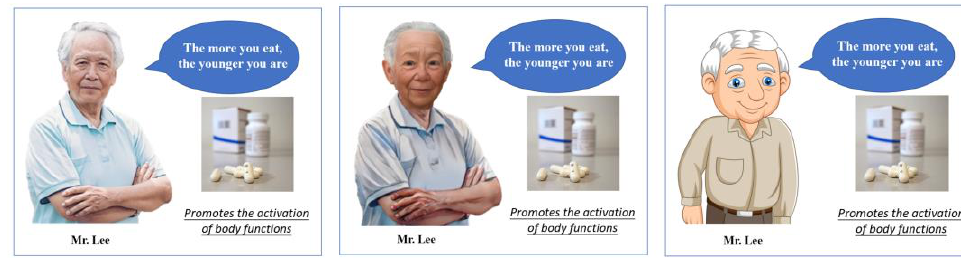
Figure 2. Endorser